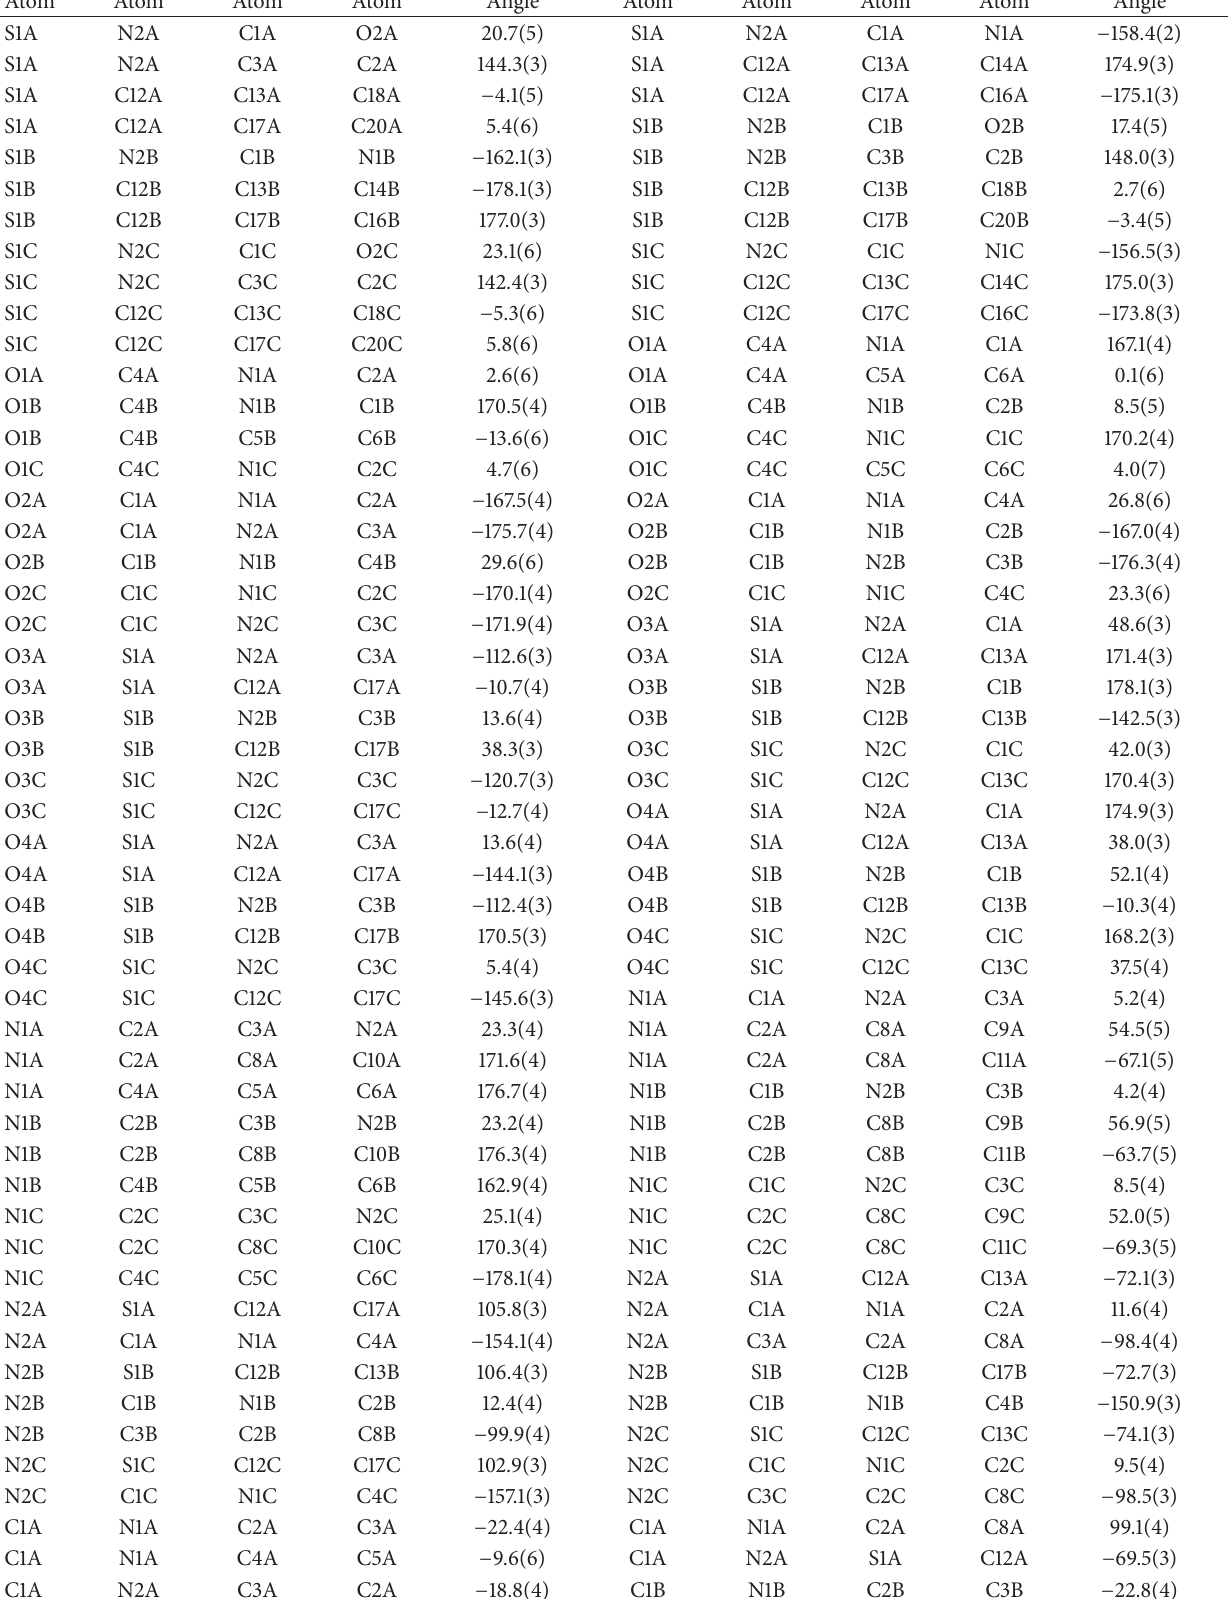
Table 4: Experimental dihedral angles